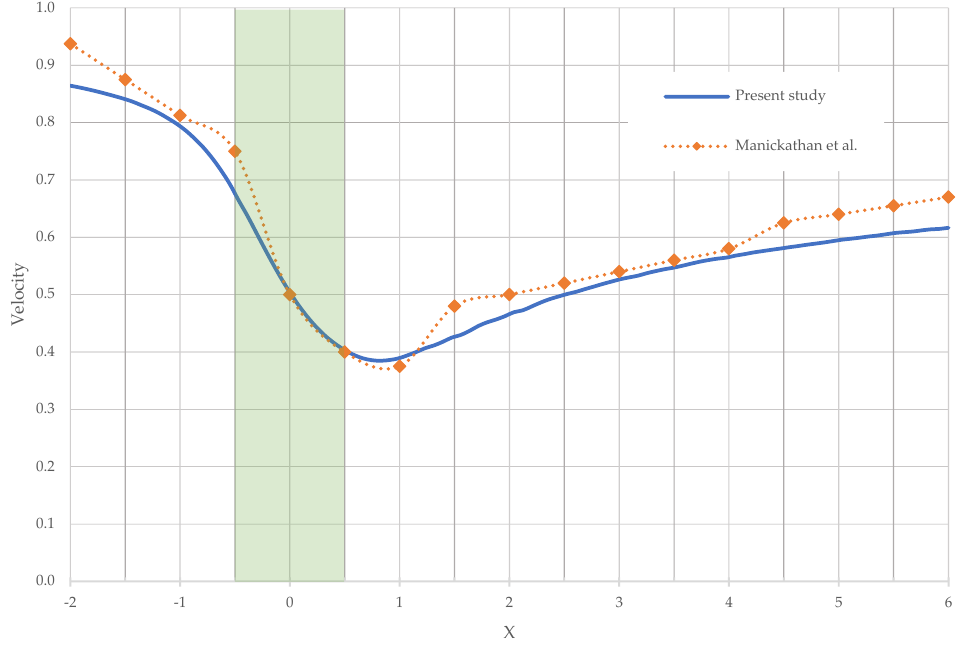
Figure 9. Comparison of wind speed along the analysis line, with the vegetation zone indicated by the green patch from −0.5 to 0.5 on the x -axis.